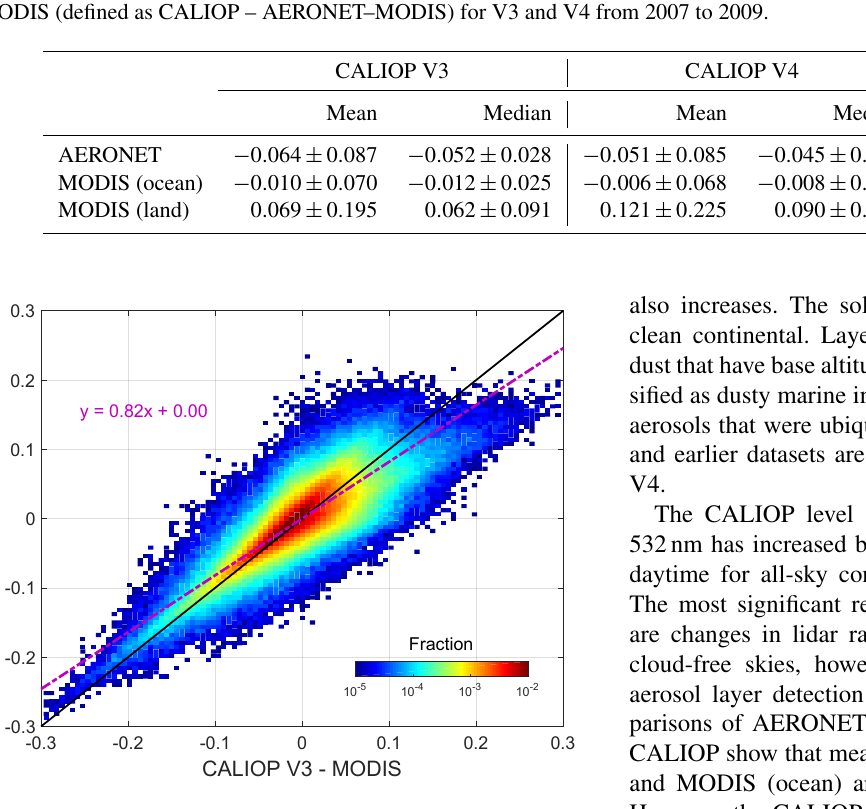
Figure 17. Distribution of V3 CALIOP AOD differences from MODIS versus the V4 CALIOP AOD differences for data acquired over ocean from 2007 to 2009. The dashed purple line shows the linear regression, with coefficients given in the